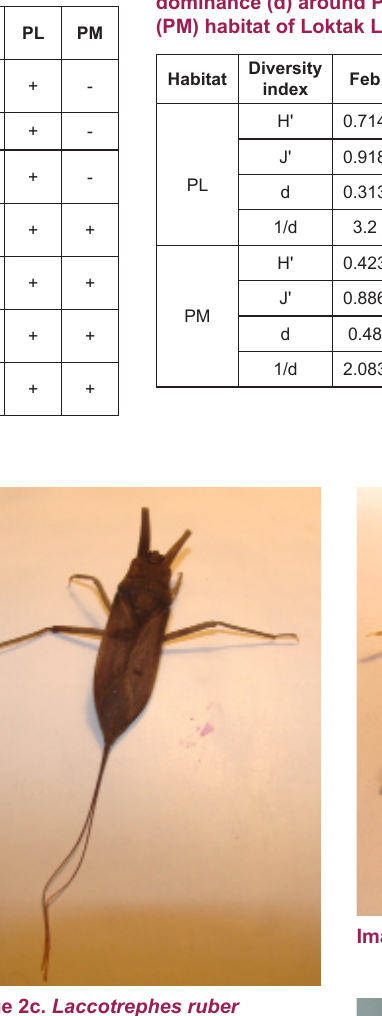
Table 1. Distribution of aquatic insects around Phumdi Live (PL) and Phumdi Mixed (PM) area of Loktak Lake.